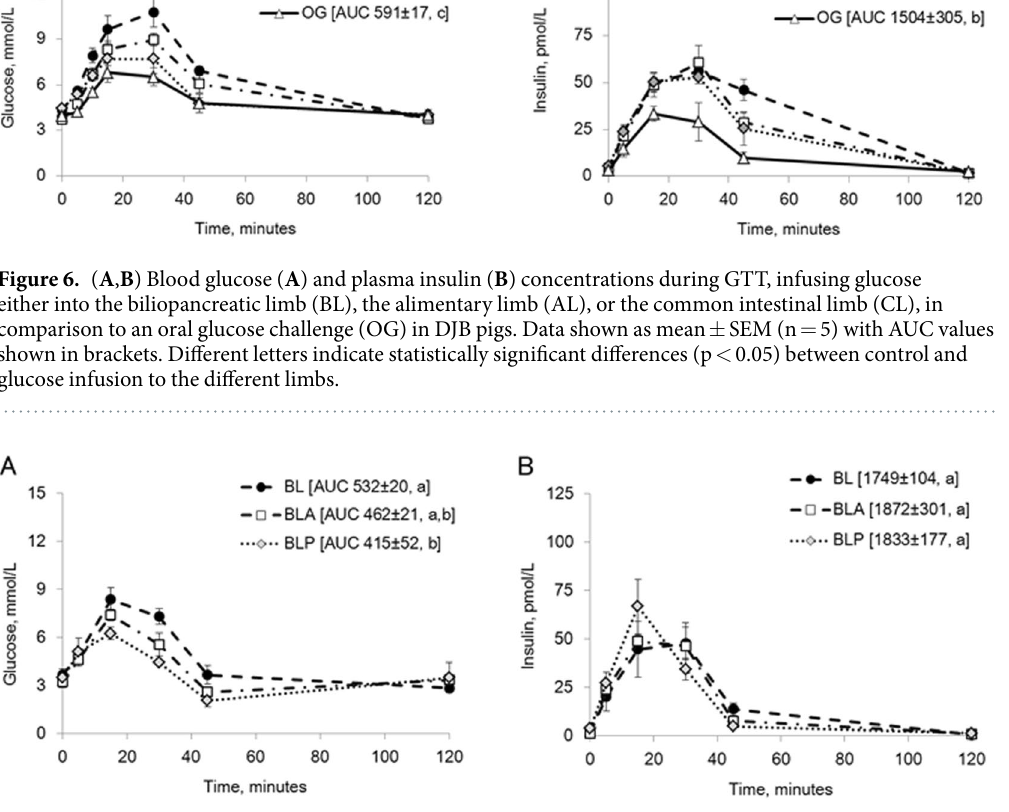
Figure 7. ( A , B ) Blood glucose ( A ) and plasma insulin ( B ) levels (in jugular vein samples) during GTT, infusing glucose to the biliopancreatic limb alone (BL), or together with amylase (BLA), or with amylase derived- peptides (BLP) in DJB pigs. Data shown as mean ± SEM (n = 3) with AUC values shown in brackets. Different letters indicate statistically significant differences (p < 0.05) between glucose infusion without (BL) and with amylase (BLA) or amylase peptide (BLP) additions.